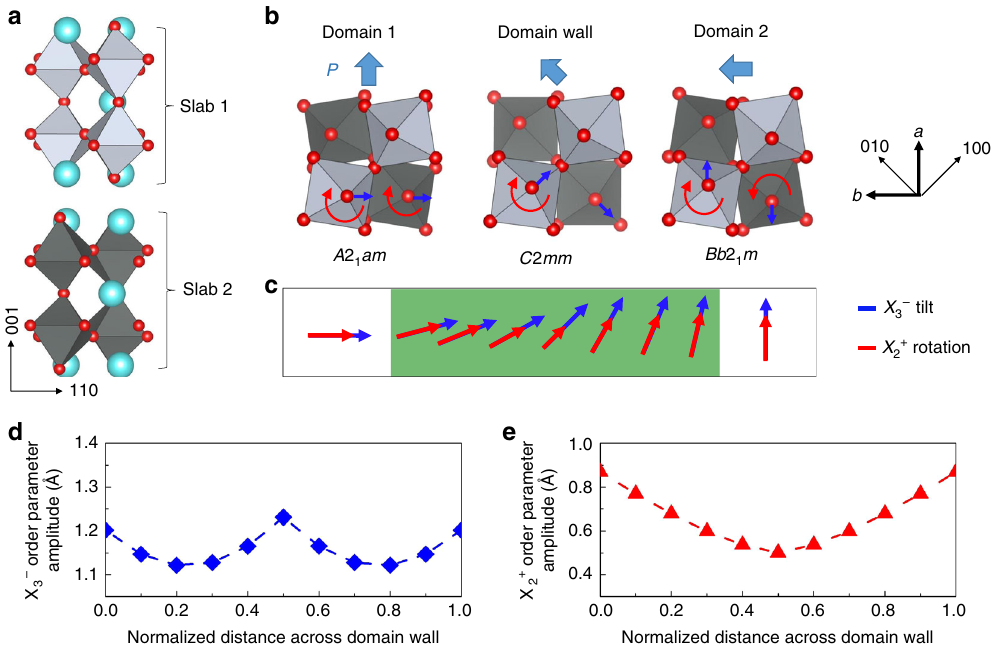
Fig. 1 Bulk crystal and ferroelastic domain wall structure. a Crystal structure of Ca 3 Ti 2 O 7 (space group A 2 1 am ). The two CaTiO 3 perovskite slabs are shown in light and dark gray, with the Ca cations in light blue. The structure of the two orthorhombic twin domains is shown in b real space and c order parameter space. The order parameters for the X (cid:3) octahedral tilt and X þ octahedral rotation are shown with blue and red arrows, respectively, in c and the 3 2 corresponding atomic motions are highlighted using the same colors in b . The bold black arrows show the setting of the orthorhombic relative to the tetragonal axes. The rotation direction of the Γ (cid:3) order parameter is indicated by the arrows with a P , indicating polarization direction, above the structures. 5 Upon crossing a ferroelastic domain wall, the octahedral rotation order parameters rotate by 90 (cid:1) ; at the midpoint, the local structure is space group C 2 mm . d , e The order parameter amplitudes are plotted as a function of the normalized wall width. These amplitudes (reported for a Z = 2 cell) were obtained using density functional theory calculations of a trajectory through the bulk energy surface. The units of these structural order parameters are that of distance (in Å ) because they are measuring the amount of distortion — which is calculated by adding up how much all of the atoms in the unit cell are displaced from their high symmetry positions. See Supplementary Information for